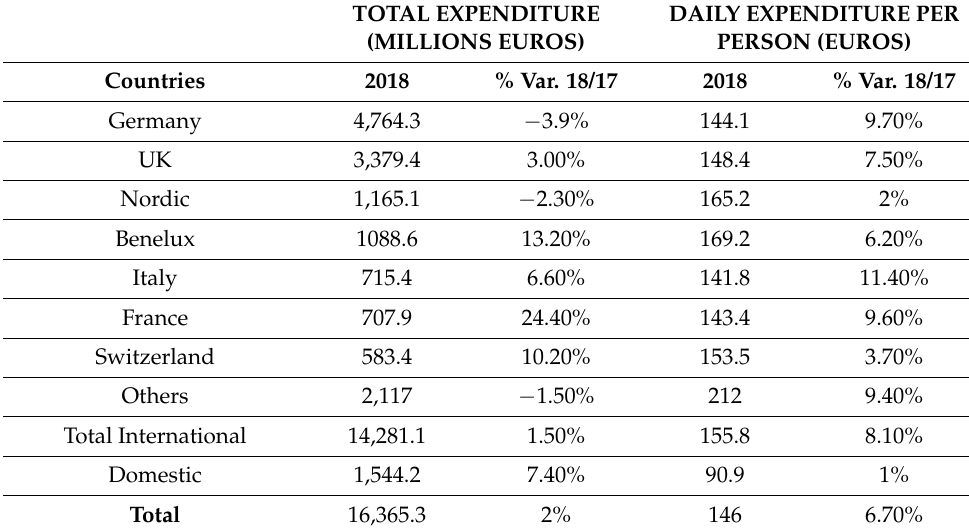
Table 8. Expenditure of tourists according to country of residence